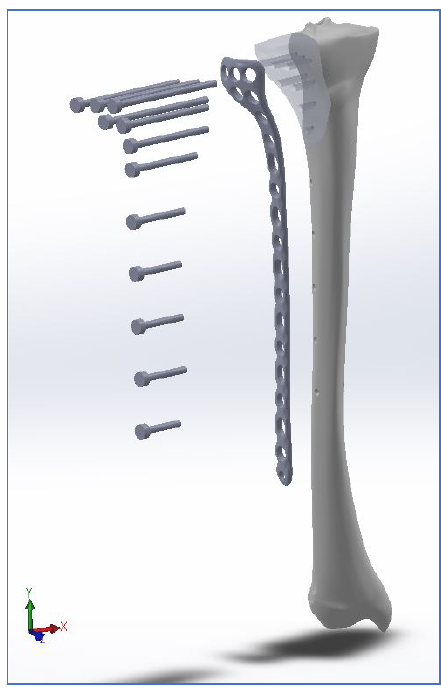
Figure 4. The exploded view of bone, plate and screws.